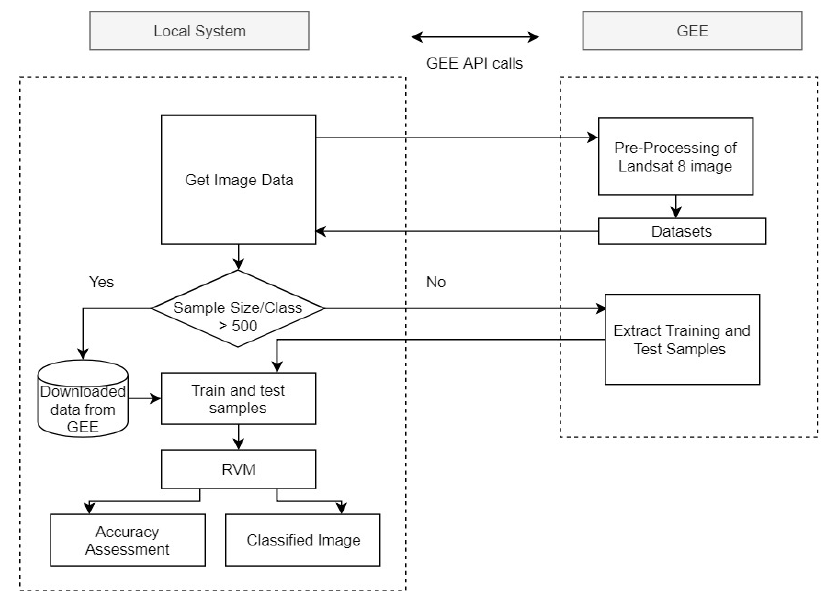
Figure 3. Roles of the local system and GEE for implementation of the Relevance Vector Machine (RVM) classifier.